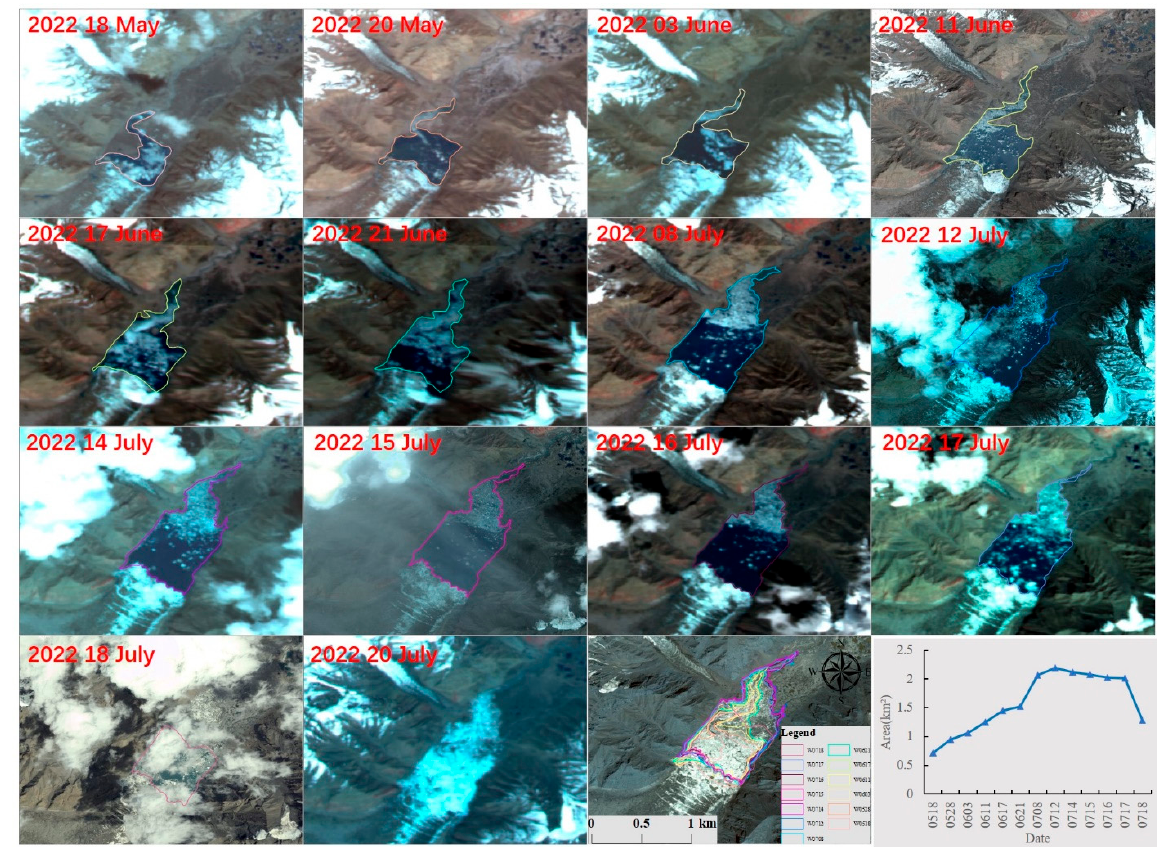
Figure 4. Lake extent change in 2022 before and after the outburst.